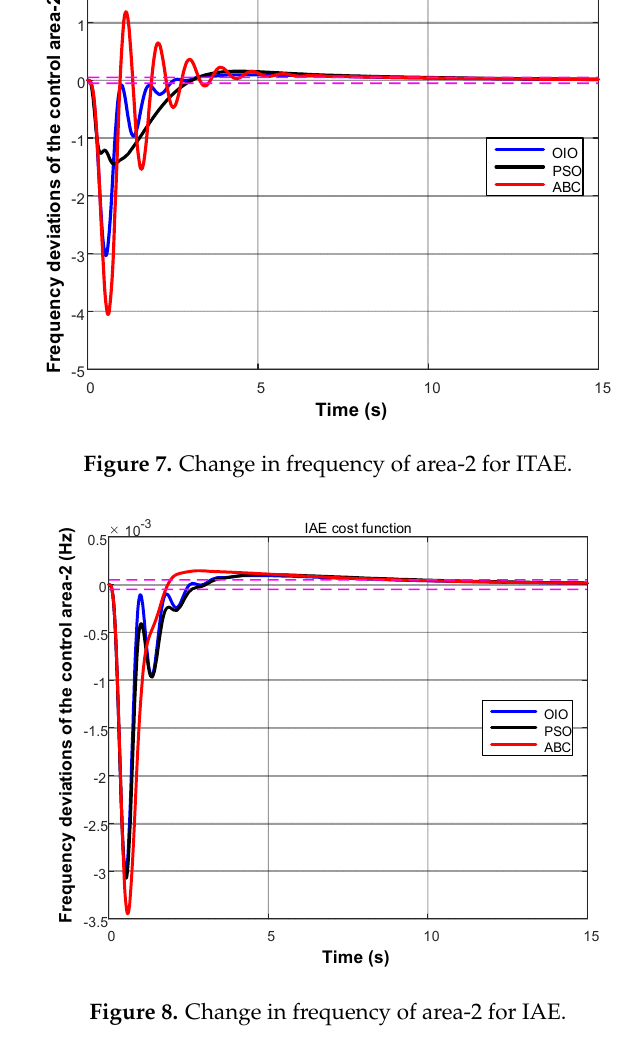
Figure 6. Change in frequency of area ‐ 1 for ITSE.